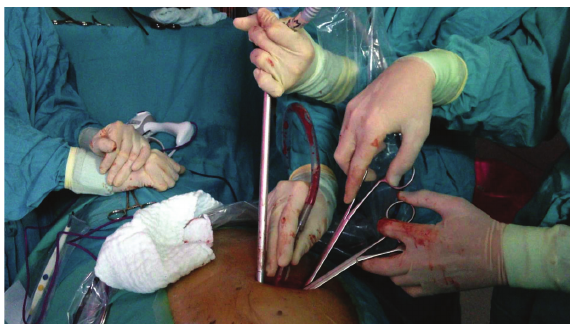
Figure 3: Surgical